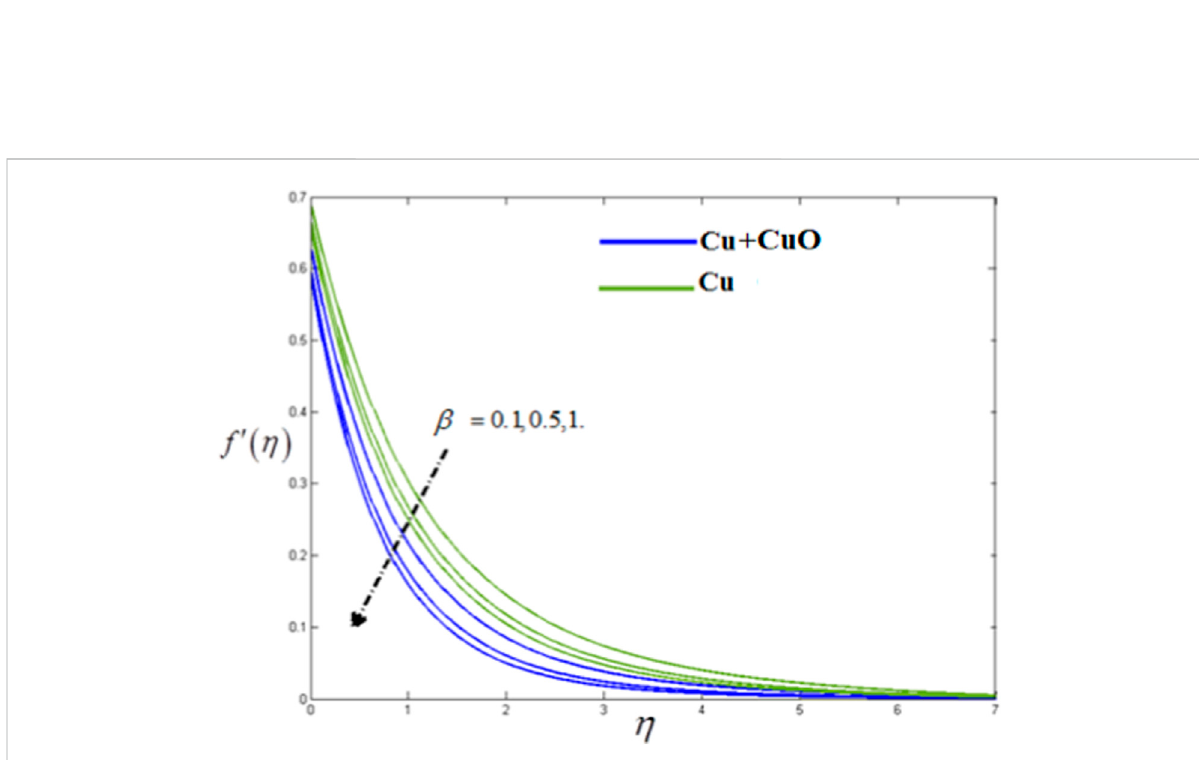
FIGURE 5 β versus ( f ′ ( η ) ). When, k (cid:2) 0 . 2 , Λ (cid:2) 0 . 4 , ϕ